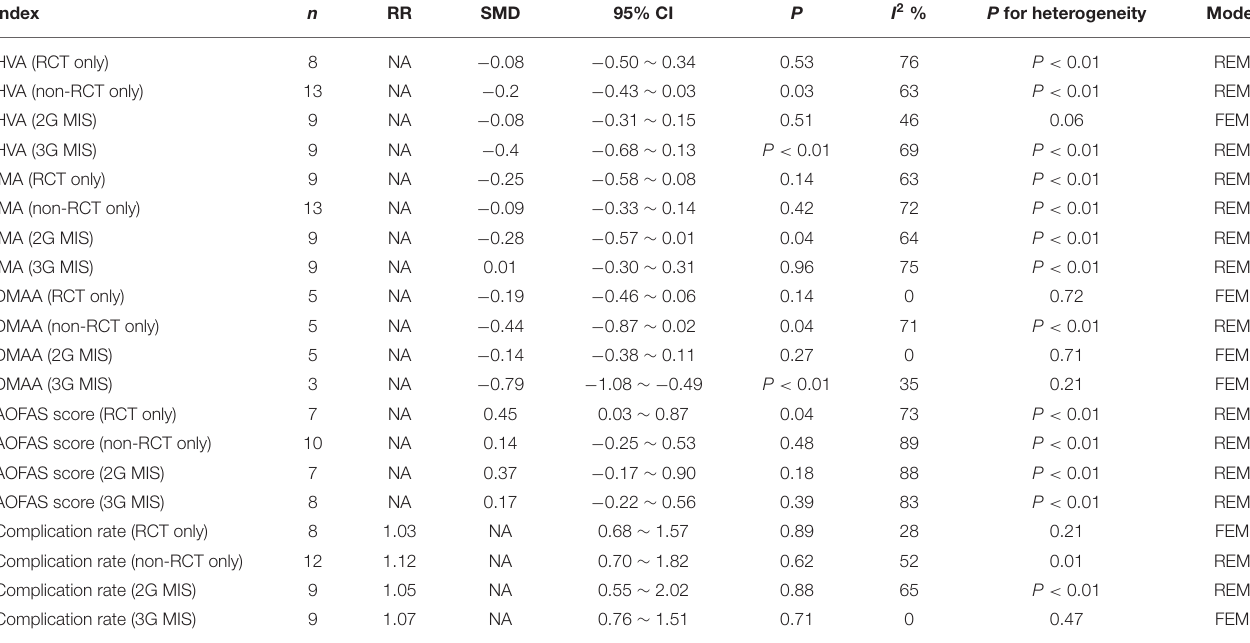
TABLE 3 | Main results of subgroup